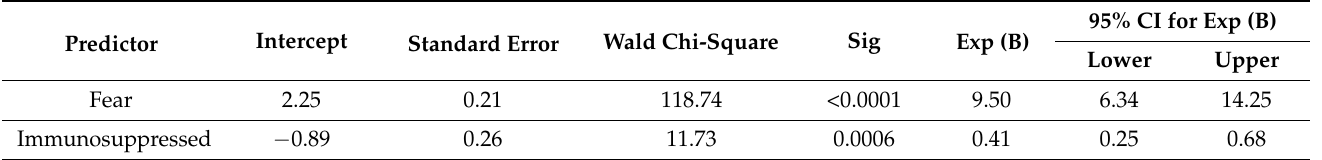
Table 5. The multifactorial model (backward stepwise regression) analyzes the significant predictors of accepting COVID-19 vaccine booster